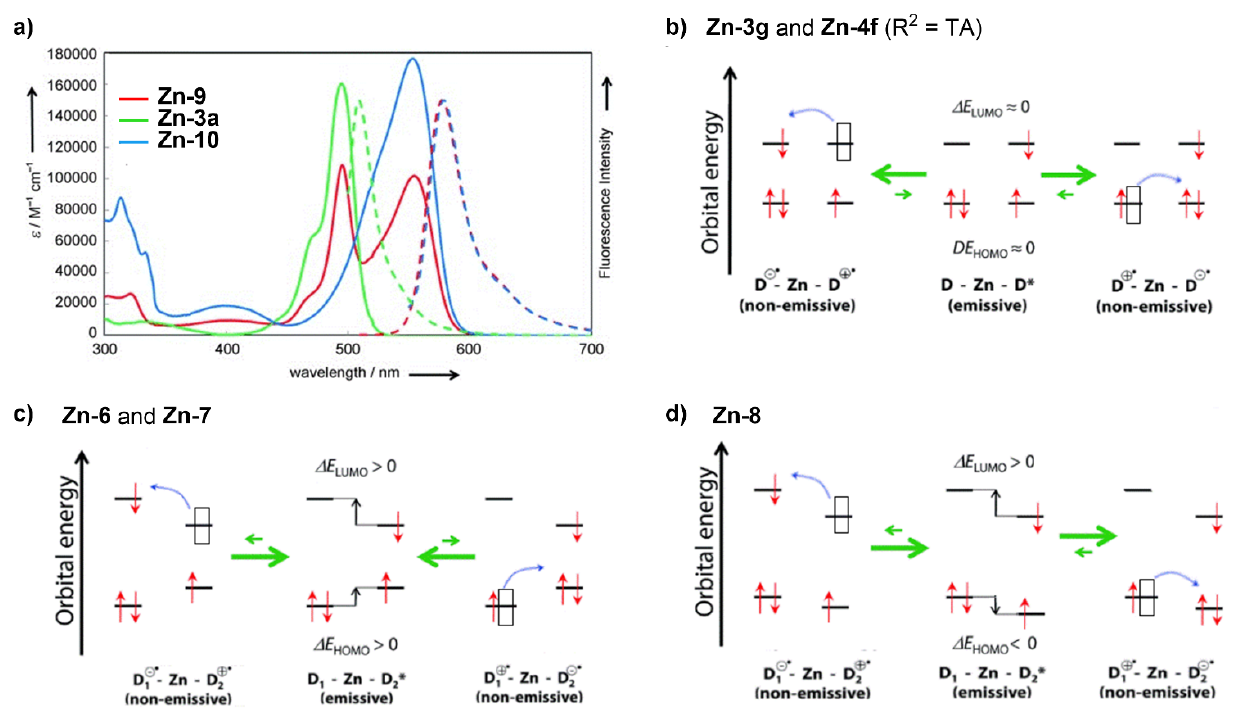
Figure 18. ( a ) Absorption spectra (solid lines) and emission spectra (dotted lines) of the heteroleptic complex Zn-6 an its homoleptic analogues Zn-3g and Zn-4f (R 2 = TA) in toluene. Schematic illustrations of the energy levels and electron transfer processes (blue arrows) in polar solvents for ( b ) homoleptic complexes Zn-3g and Zn-4f (R 2 = TA) ( c ) Zn-6 and Zn-7 , and ( d ) Zn-8 . Reproduced with permission from [165]. Copyright © 2012 John Wiley & Sons.